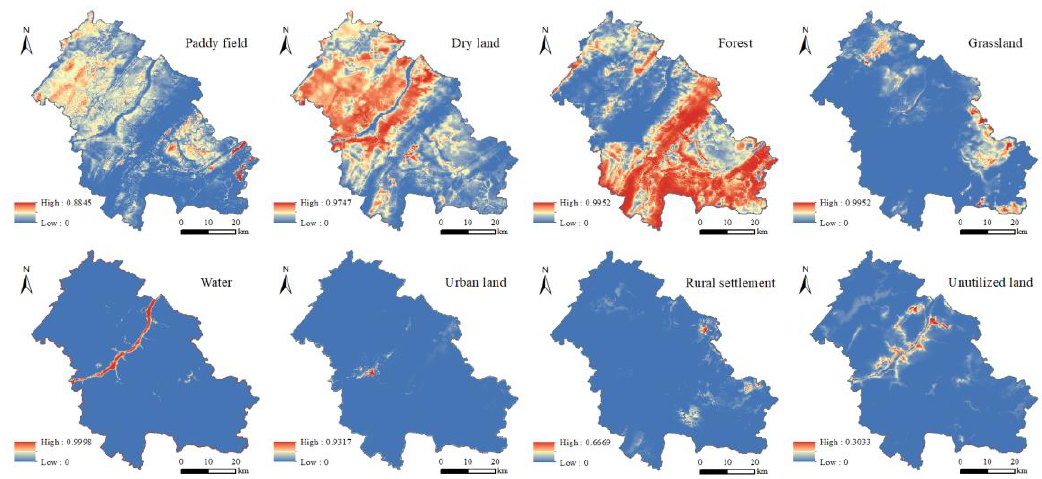
Figure 4. Probability of suitability for each land use type.